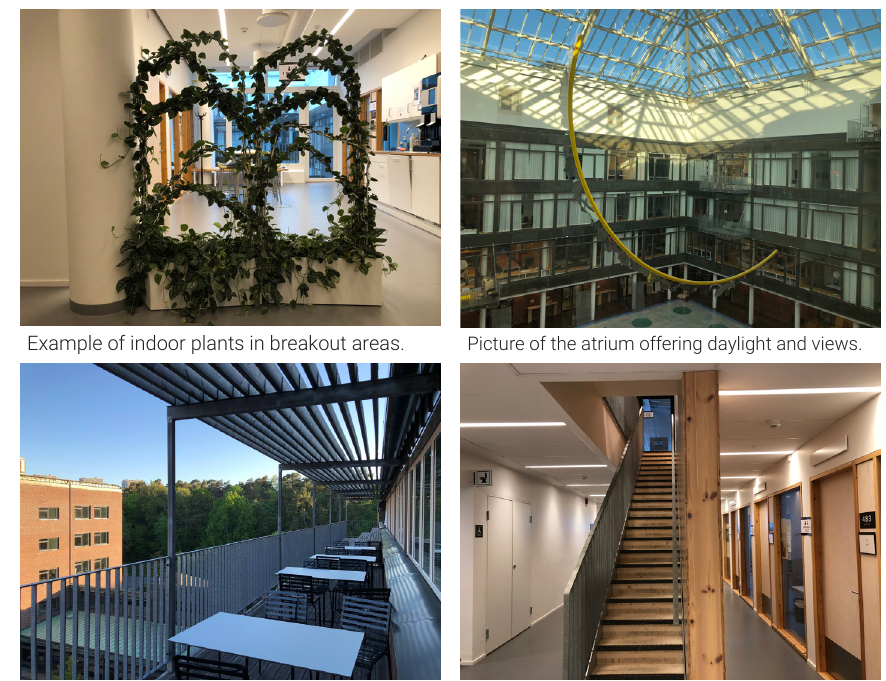
Figure 11. Nature references.